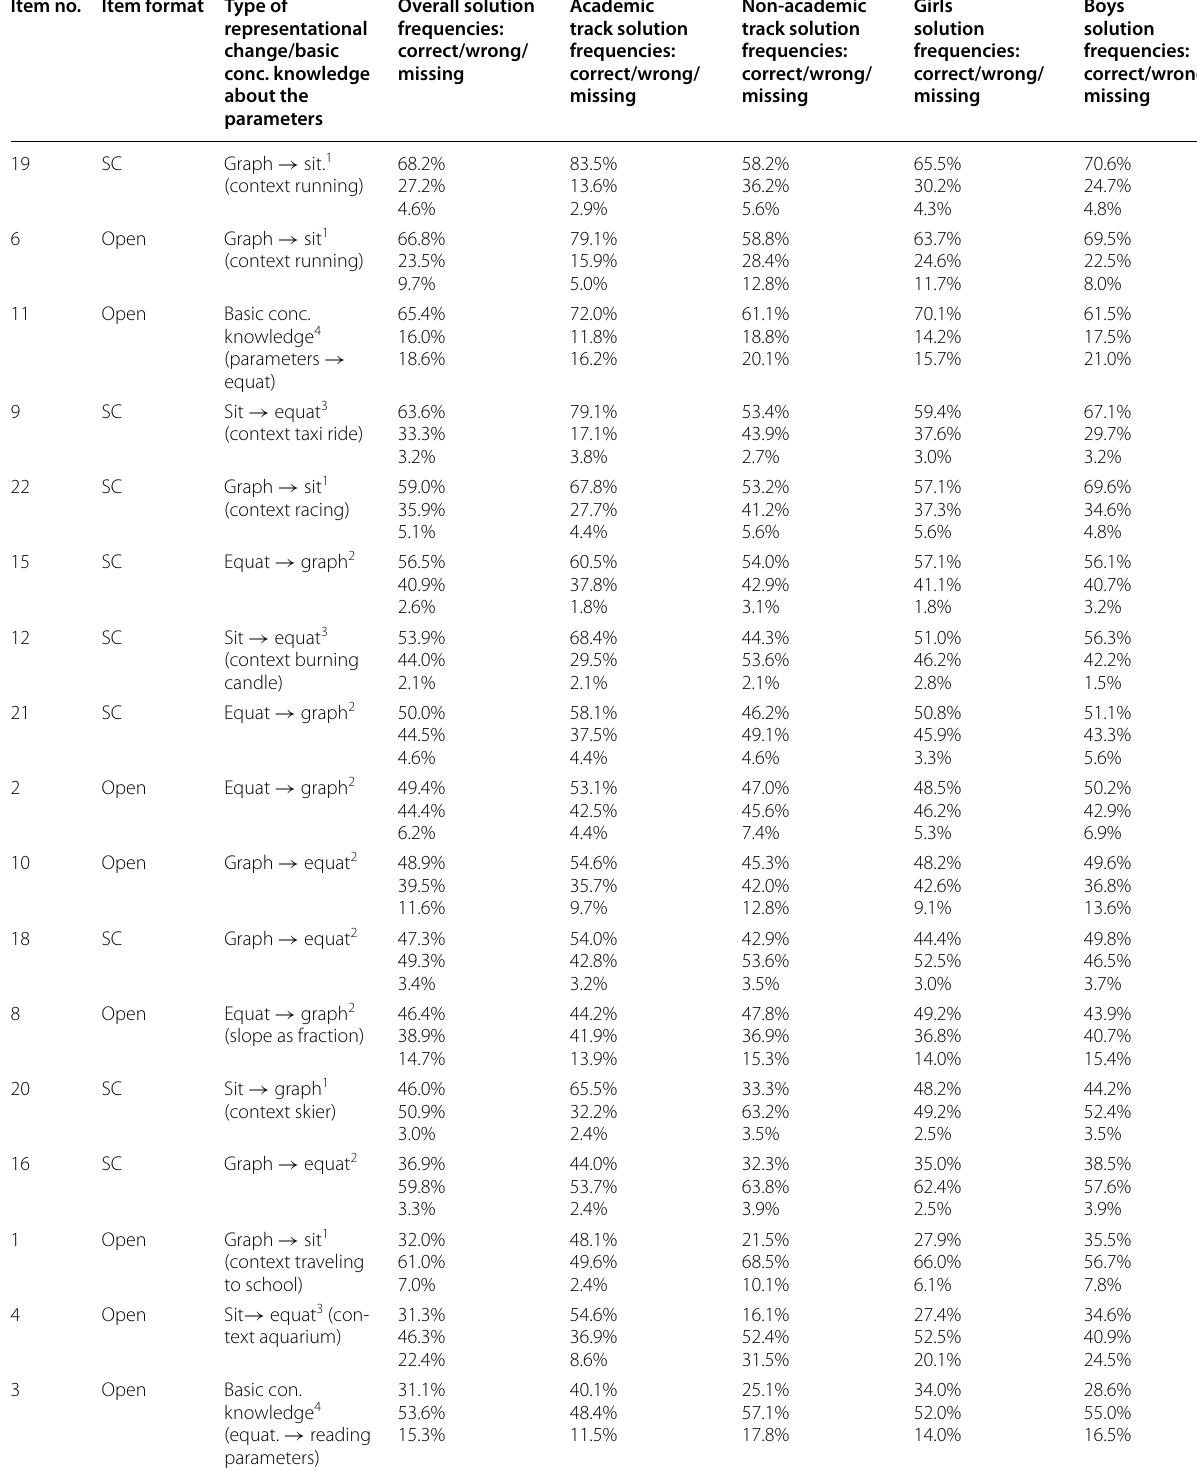
Table 1 Overview of test items and solution frequencies Item no. Item format Type of